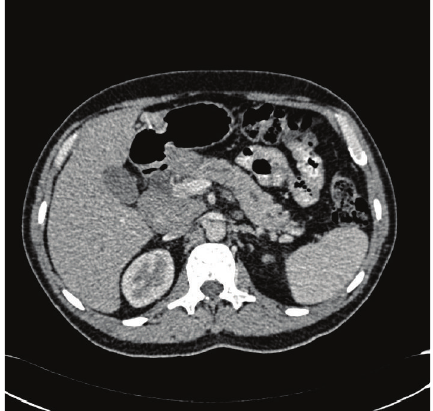
Figure 1: Initial presentation. Periampullary (pancreatic head) mass and dilated pancreatic